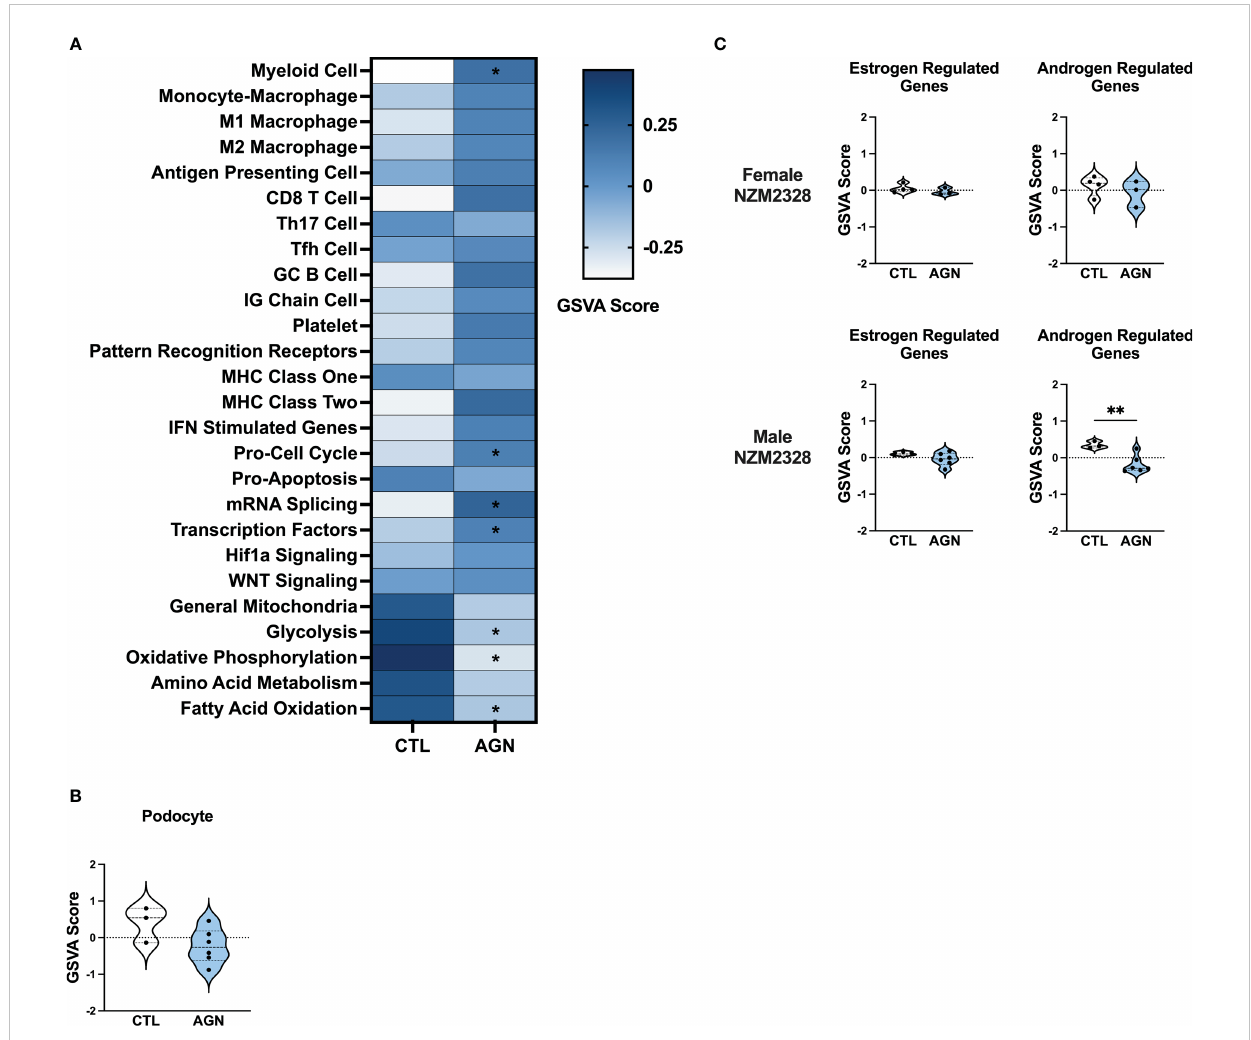
FIGURE 3 Male NZM2328 mice lack in fl ammatory signature enrichment associated with progression to chronic GN. (A) Heatmap of GSVA scores for enrichment of immune cell and pathway gene signatures in glomeruli of male CTL and AGN mice. Asterisks indicate signi fi cant comparisons with CTL mice. (B) GSVA enrichment of podocytes in cohorts shown in (A) . (C) GSVA enrichment of signatures for estrogen-regulated and androgen- regulated genes in glomeruli of female and male AGN mice. *p<0.05,